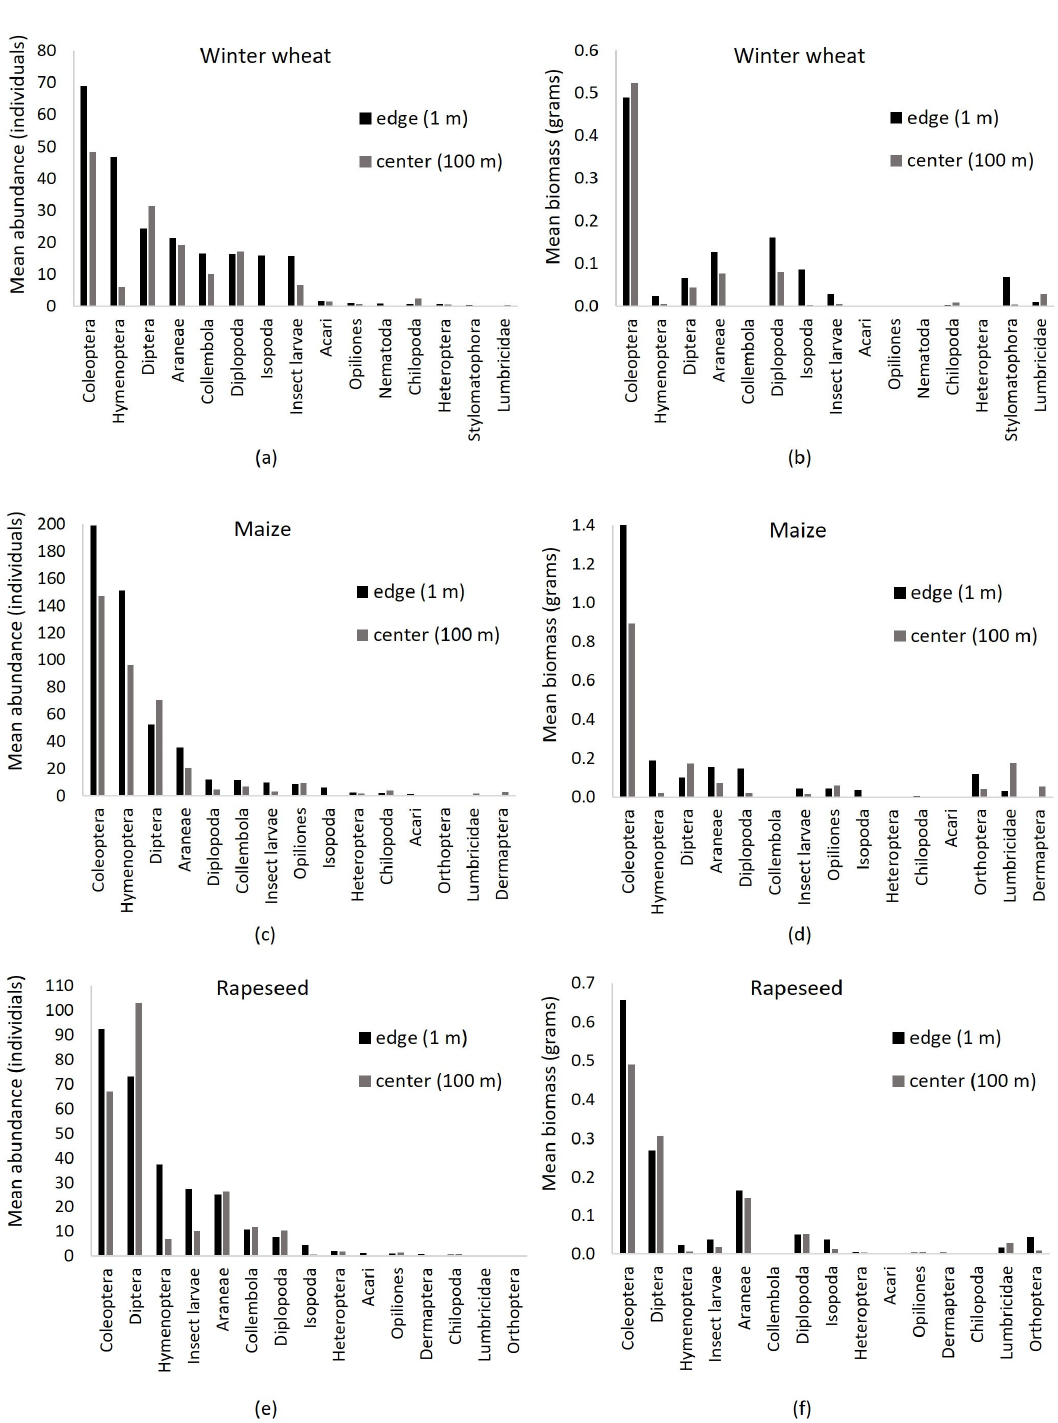
Figure 4. Mean ( a , c , e ) abundance and ( b , d , f ) biomass of individual taxa in each crop type at two different distances from the field edge. For each crop type, the figure shows the 15 most represented taxa, ordered from the most to the least numerous groups at the field edge.